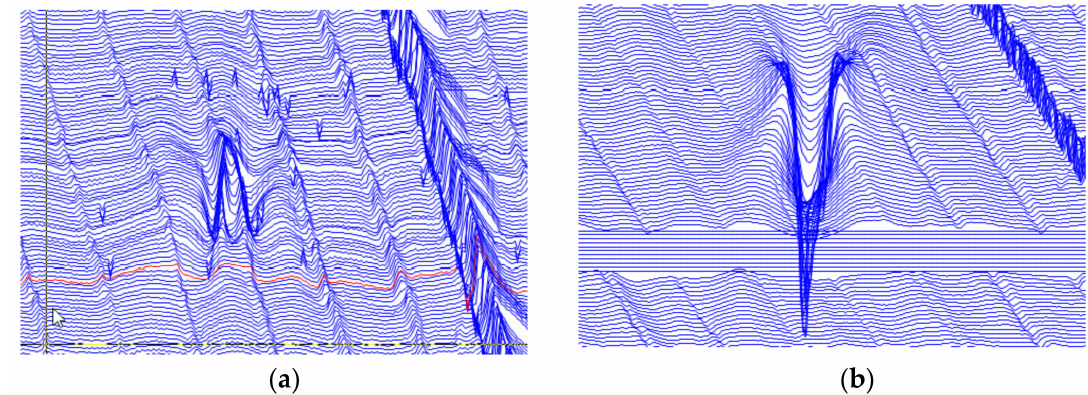
Figure 21. The MFL signals in different years: ( a ) Tangential component of first year MFL signal; ( b ) Tangential component of second year MFL